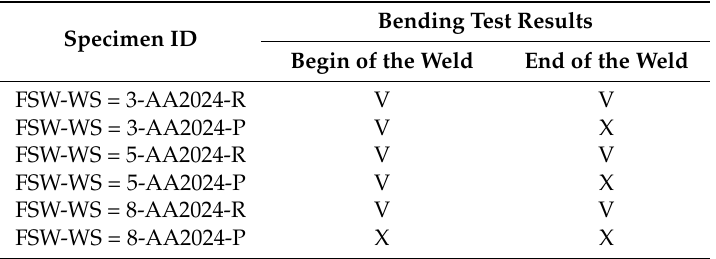
Table 6. Results of the bending test for the material direction and AA2024-T3 in the AS. Specimen ID